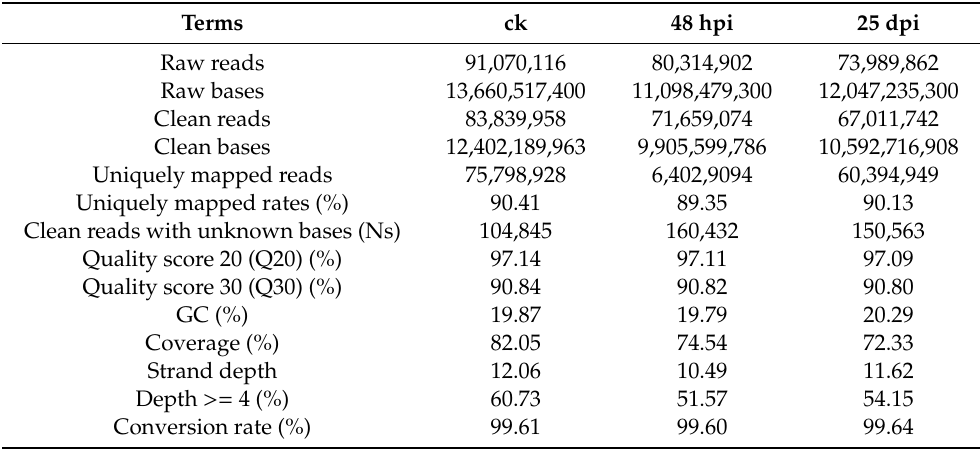
Table 1. Summary of genome-wide methylation sequencing data